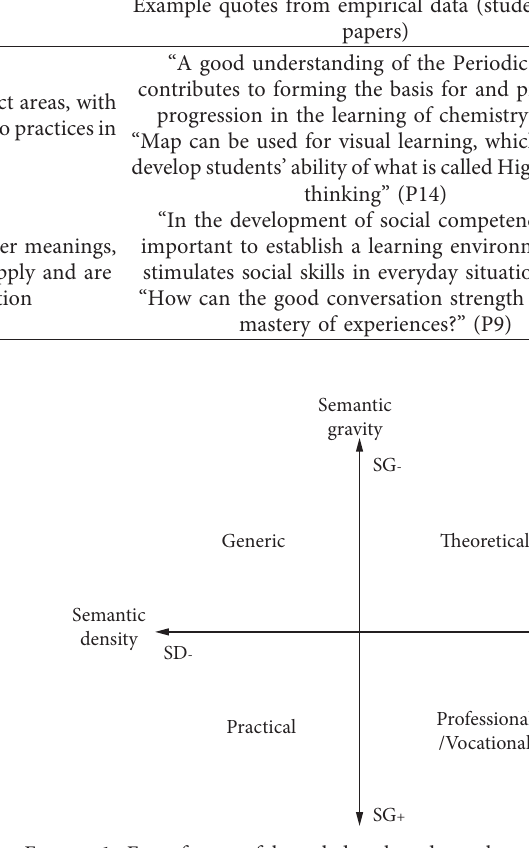
Figure 1: Four forms of knowledge, based on the concepts of semantic gravity (SG) and semantic density (SD) (Figure 1 is reproduced from Shay,